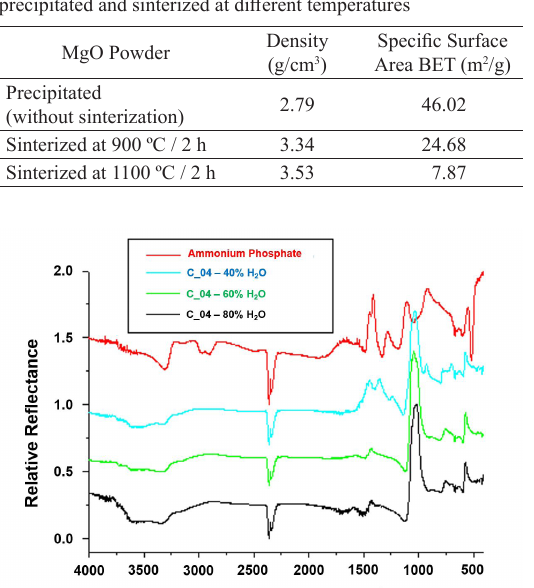
Figure 5. FTIR spectra of magnesium phosphate cements with different water contents, containing MgO powders calcined at 1100 ºC.